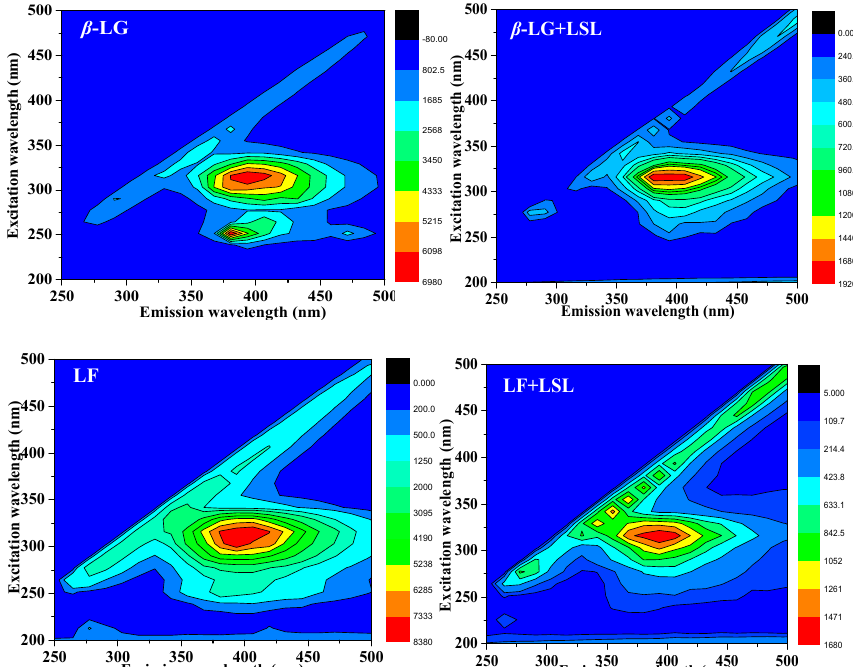
Figure 2. 3D fl uorescence spectral plots of the interaction for LSL with β − LG/LF. The protein con- Figure 2. 3D fluorescence spectral plots of the interaction for LSL with β -LG/LF. The protein centration was fi xed at 1 g/L, and the concentration ratio of protein to LSL was 5:1. concentration was fixed at 1 g/L, and the concentration ratio of protein to LSL was Table 2. Three-dimensional fl uorescence spectral parameters of β -LG/LF and LSL. Peak a Peak b Peak Position λ ex / λ em (nm/nm)